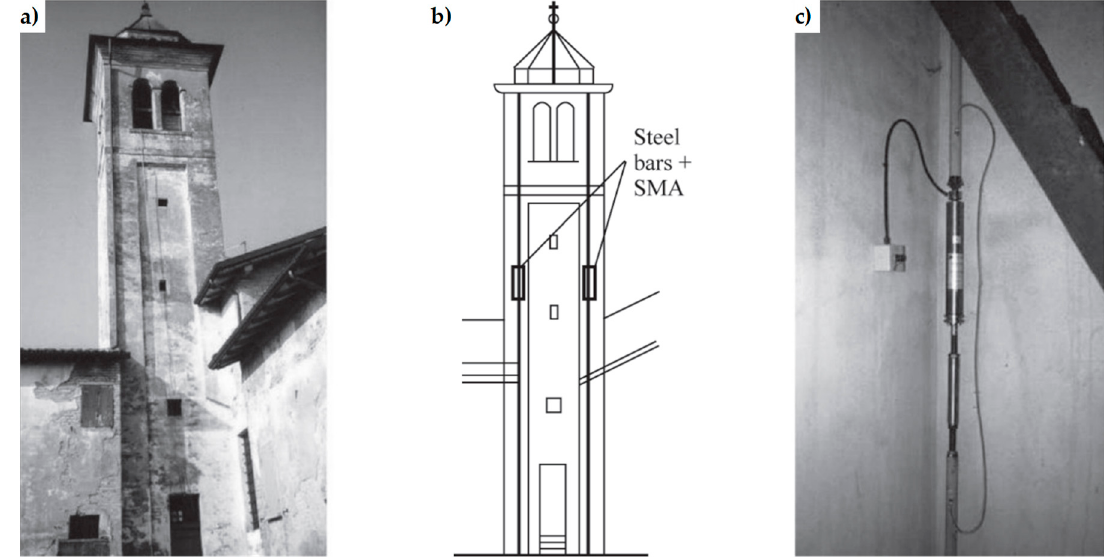
Figure 7. The bell tower of the church of San Giorgio in Trignano (Italy): ( a ) external view; ( b ) strengthening scheme; ( c ) detail of the coupling between Shape Memory Alloy (SMA) and a vertical steel tendon [22].